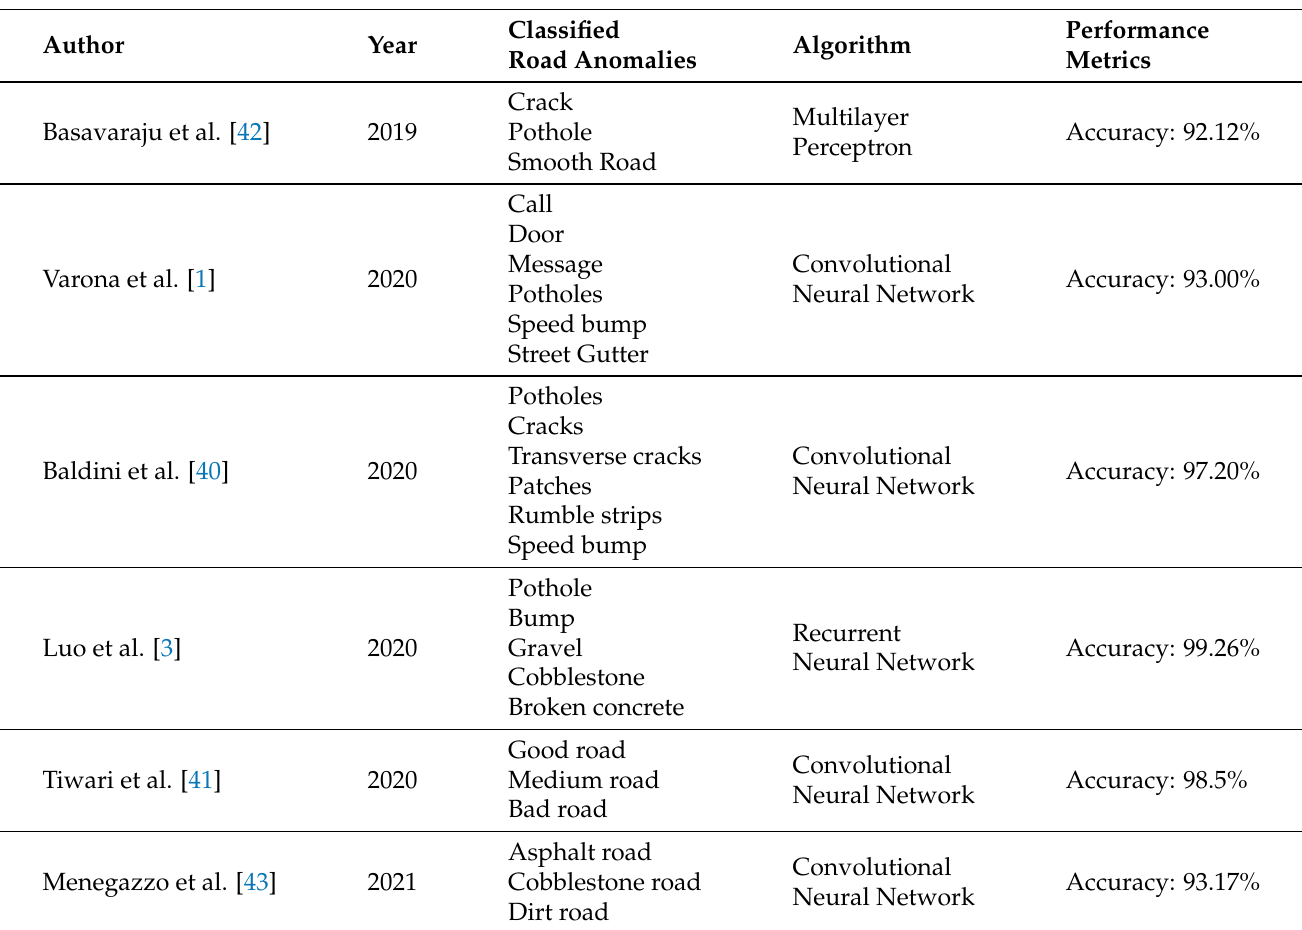
Table 5. Methods used for road anomaly detection and classification based on deep learning